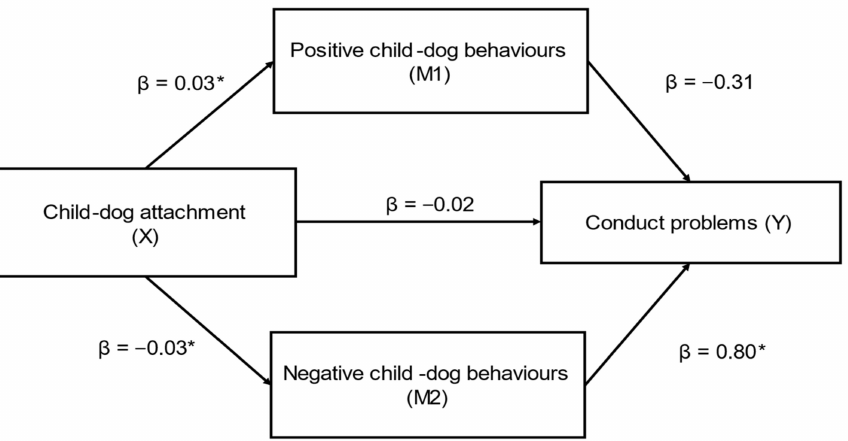
Figure 2. Positive and negative child–dog behaviours as mediators in the relationship between child– dog attachment and caregiver-reported conduct problems (SDQ) ( n = 83) (ab cs = − 0.23, medium effect). Note: * = significant pathway.